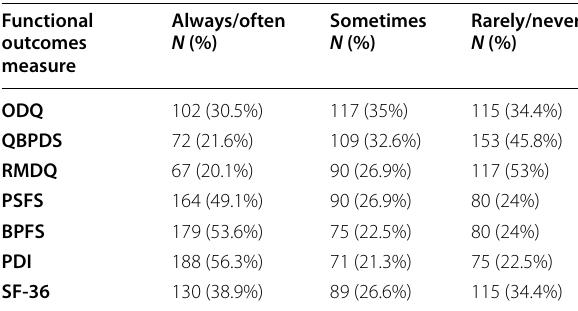
Table 2 Frequency of the use of functional outcome measure to assess function and disability impairment and improvement within the patient with low back pain